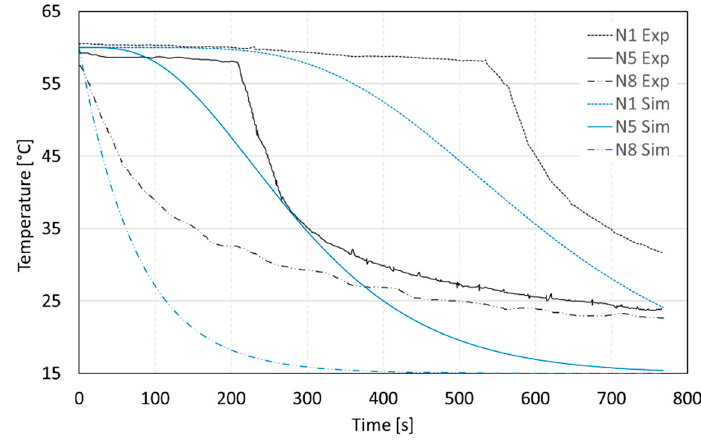
Figure 17. Temperature evolution during the discharge phase—experimental vs. simulated—5 dm 3 /min volume flow rate.